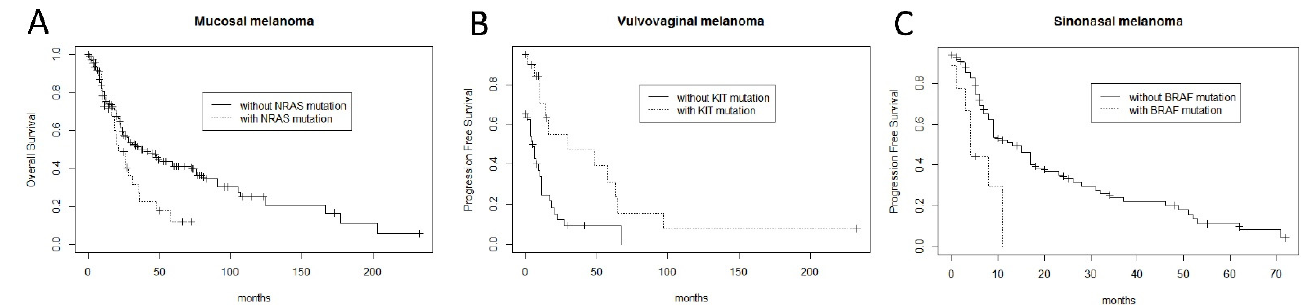
Figure 4. Kaplan–Meier curves demonstrate significant correlation between: ( A ) worse overall survival and NRAS mutation in mucosal melanomas (log-rank p = 0.028); ( B ) better progression-free survival and KIT mutation in vulvovaginal melanomas (log-rank p = 0.0021); ( C ) worse progression-free survival and BRAF mutation in sinonasal melanomas (log-rank p = 0.0045).